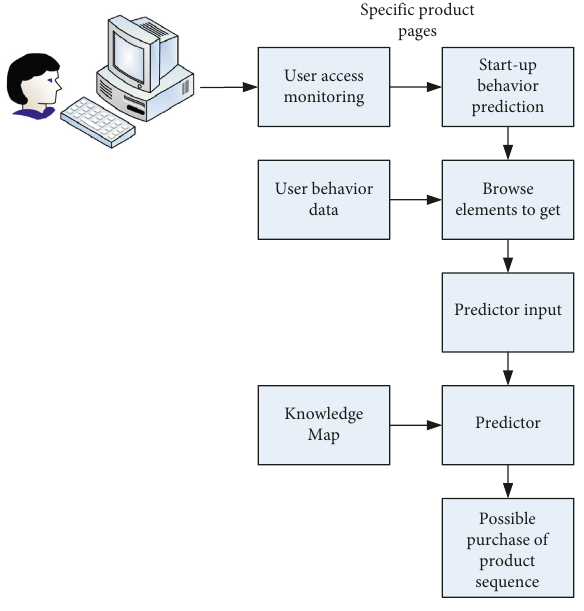
Figure 5: Prediction flow